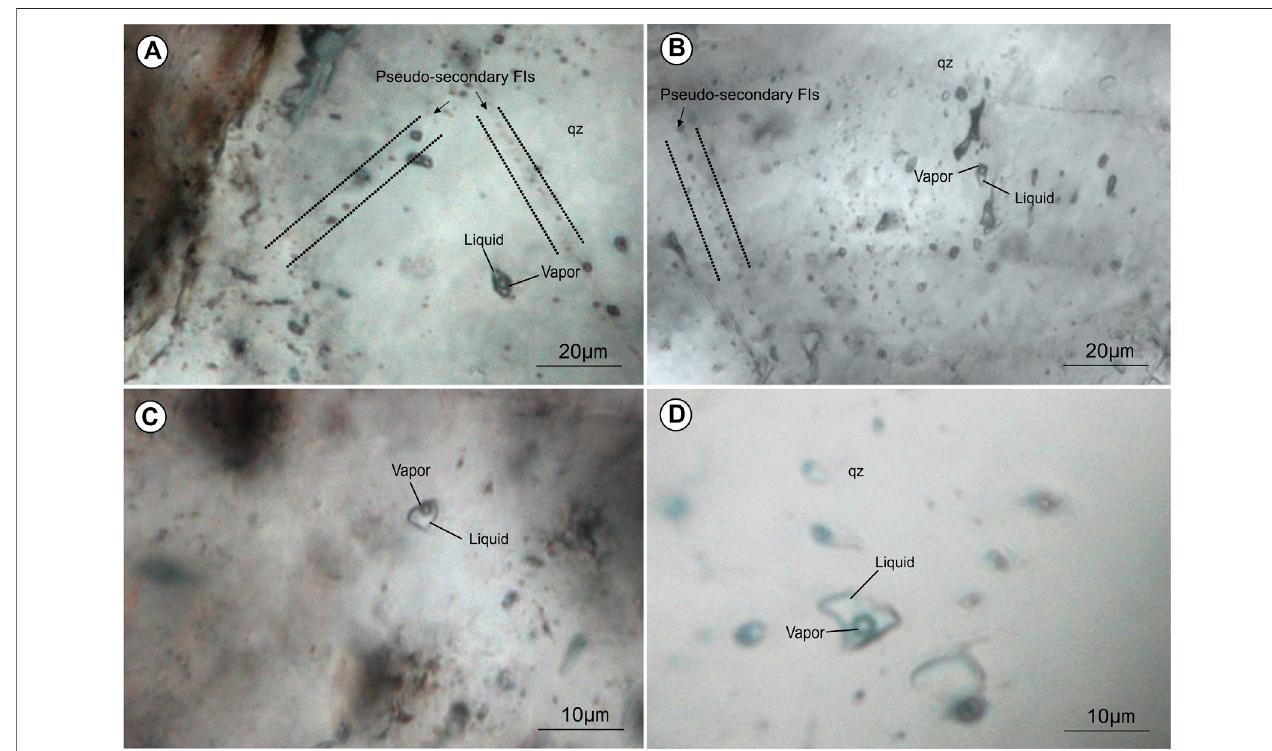
FIGURE 10 | (A) Photomicrographs of fl uid inclusions in gold-bearing quartz vein from Shwetagun at room temperature in plane-polarized light. (a) and (B) Type A (vapor-rich) and Type B (liquid-rich) fl uid inclusions coexisting together within same quartz gain in gold-bearing quartz vein from adit-I, (C) Type B (liquid-rich) fl uid inclusions in quartz of the gold-bearing quartz vein from adit-I; and (D) Type B (liquid-rich) fl uid inclusions in quartz of the gold-bearing quartz vein from adit-III. Abbreviations: qz (cid:1) quartz.